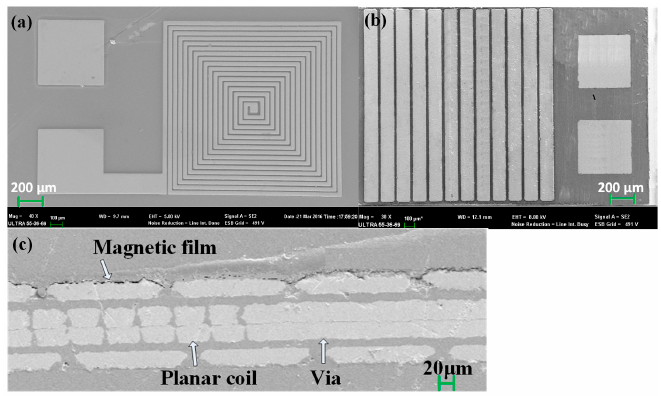
Figure 8. Scanning electron microscope (SEM) images of the fabricated planar inductor with patterned magnetic film. ( a ) Upper Cu coil; ( b ) profile of the mocro-inductor; ( c ) cross section of the micro-inductor.